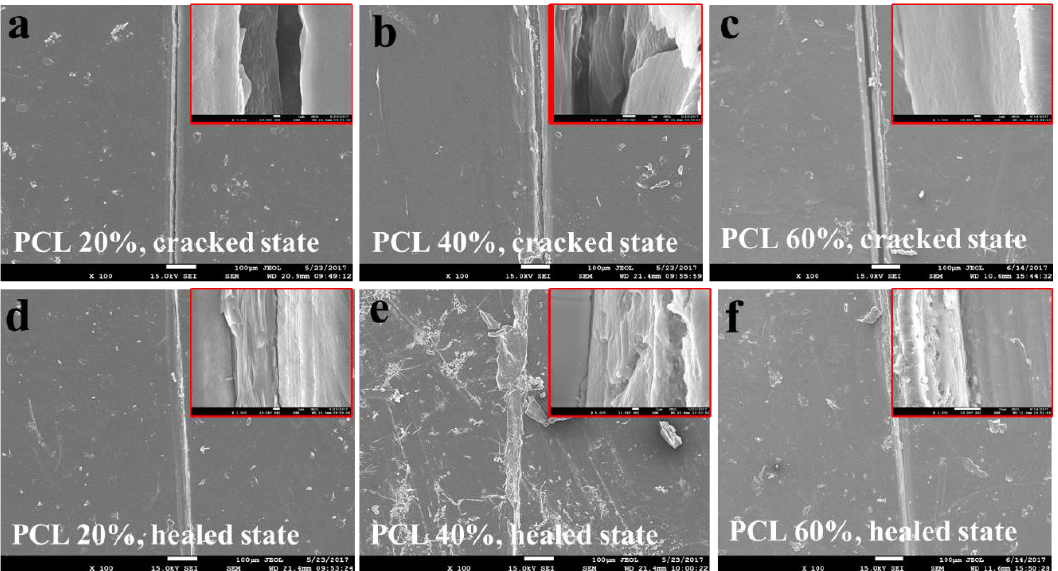
Figure 5. SEM images of the cracked areas before and after self-healing corresponding to 20% ( a , d ); 40% ( b , e ); 60% ( c , f ) PCL contents of the samples, respectively.